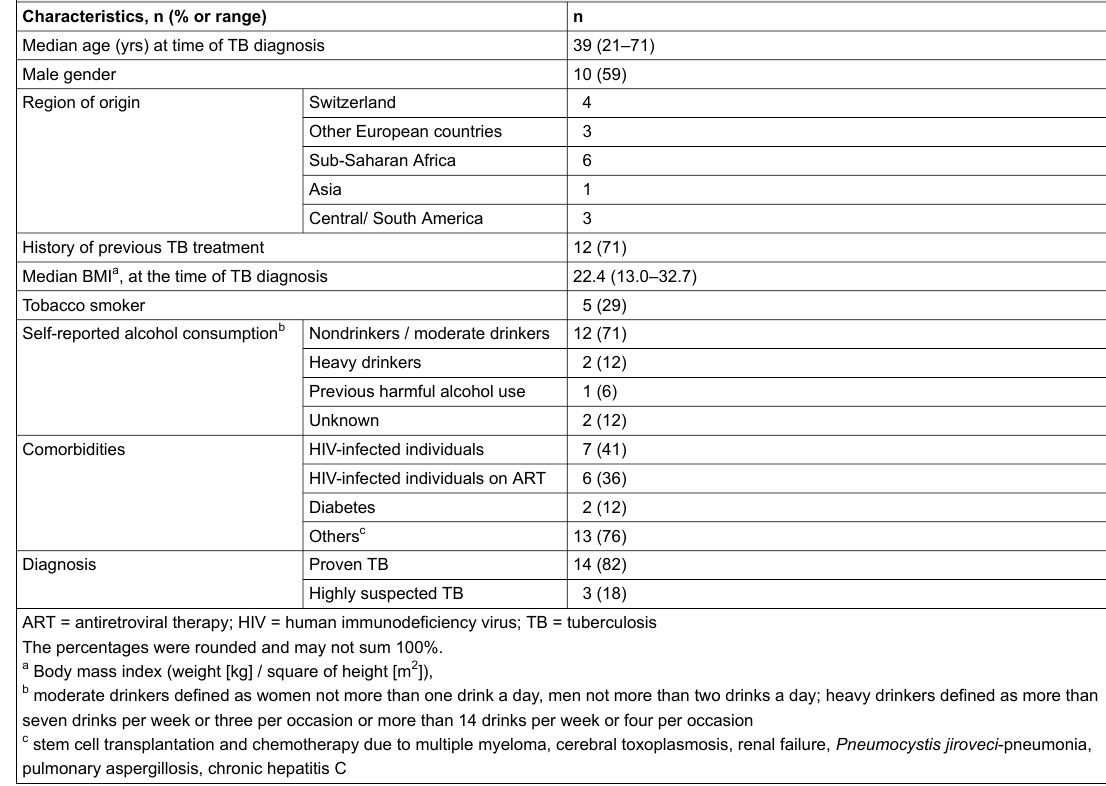
Table 2: Individual eC maxa of isoniazid (INH), rifampicin (RMP), rifabutin (RFB), pyrazinamide (PZA), and ethambutol (EMB) and outcome of tuberculosis (TB). Patient TB